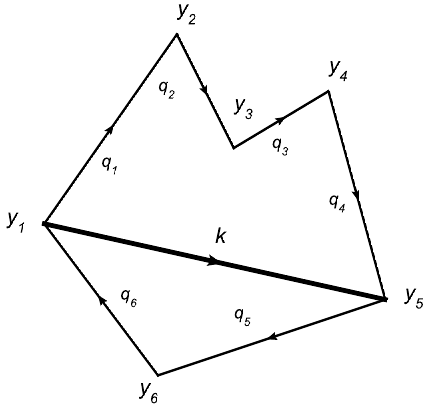
Figure 5 . Momenta and dual coordinates in the case of the amplitude with one off-shell and n = 4 on-shell legs. In contrast to the case of the on-shell amplitudes, the n on-shell momenta do not add up to zero but to the off-shell gluon momentum k : q 1 + . . . + q 4 = k , which in its turn can be decomposed as a pair of auxiliary on-shell momenta k = q 5 + q 6